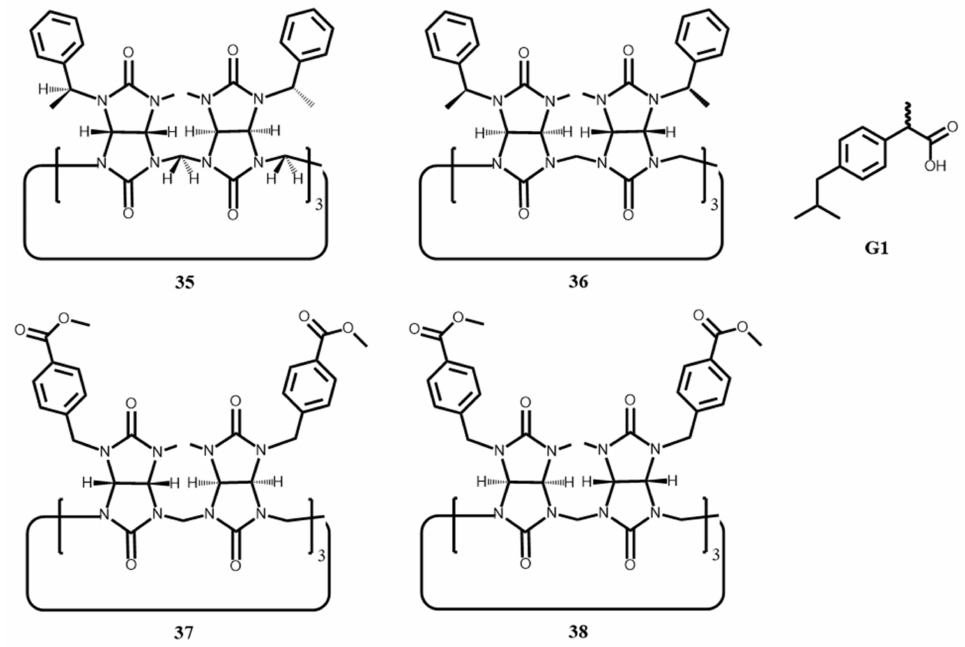
Figure 14. The chemical structure of chiral